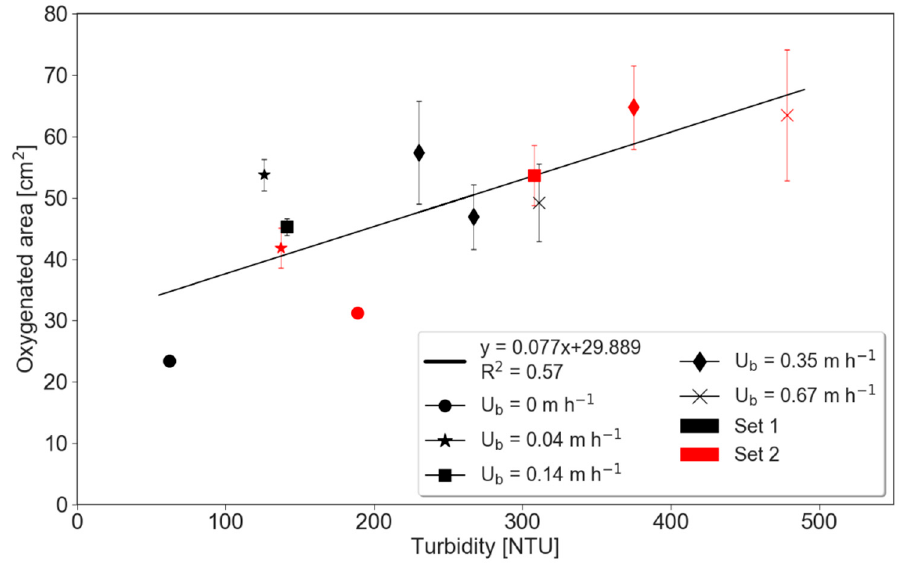
Figure 4. Relationship between oxygenated area and surface water turbidity. The experimental conditions, labelled by their celerities, are additionally separated into Set 1 and 2 (first and second run of the same celerity). Whiskers denote standard deviations.